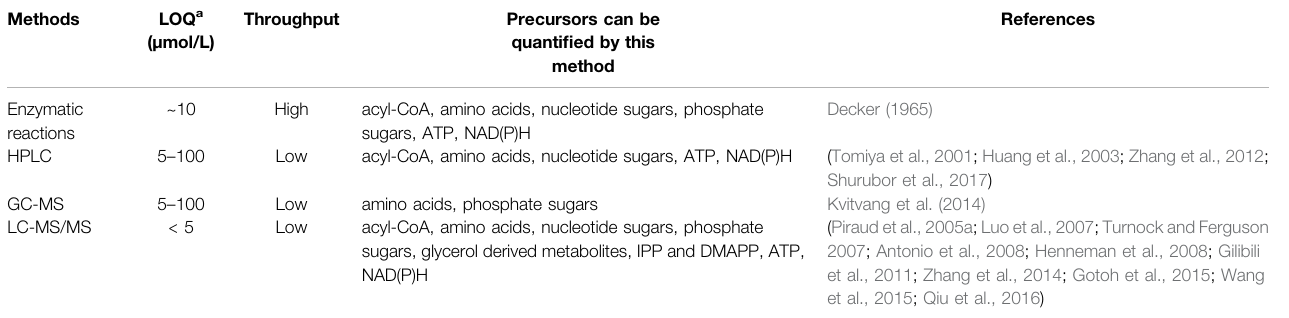
TABLE 3 | Comparison of the methods mentioned in this